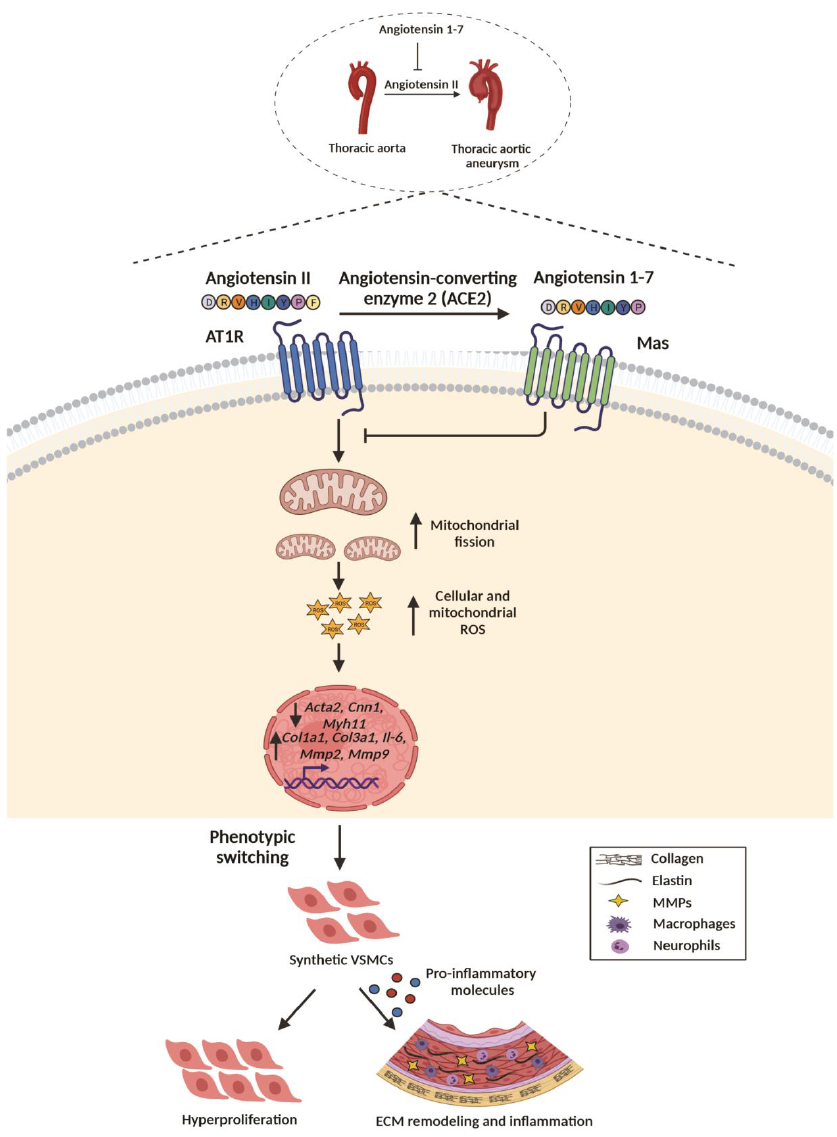
Figure 6. Ang 1-7 attenuates TAA by antagonizing Ang II-mediated pathological changes in tho- racic aortic SMCs. Chronic infusion of Ang II, an effector protein of the renin-angiotensin system (RAS), leads to the development of thoracic aortic aneurysm (TAA) in ApoEKO mice. Mechanistically, Ang II treatment results in excessive mitochondrial fission in thoracic aortic SMCs, which conse- quently results in increased cellular and mitochondrial ROS. Ang II-induced oxidative stress affects the expression of various genes promoting the polarization of VSMCs to a synthetic, proliferative, and inflammatory phenotype. Ang 1-7 antagonizes pathogenic effects of Ang II and attenuates excessive mitochondrial fission, oxidative stress, inflammation, and phenotypic switching of thoracic aortic SMCs, resulting in attenuation of TAA development in ApoEKO mice. Figure created using